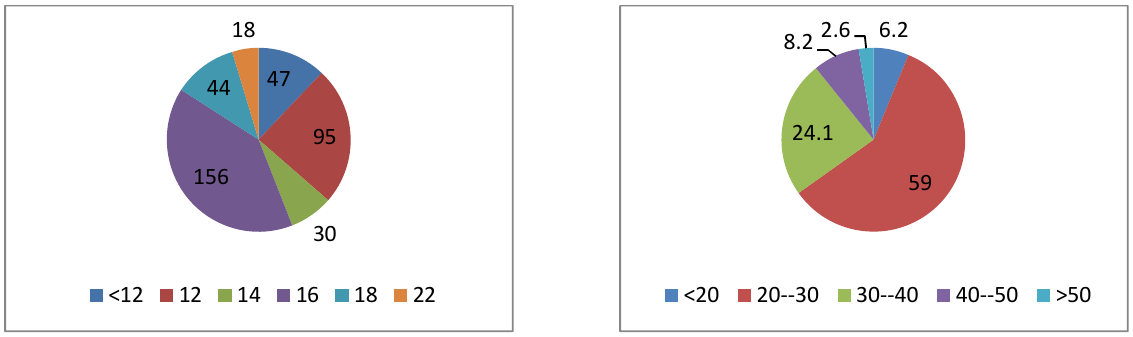
Fig. 1. Personal characteristics of the